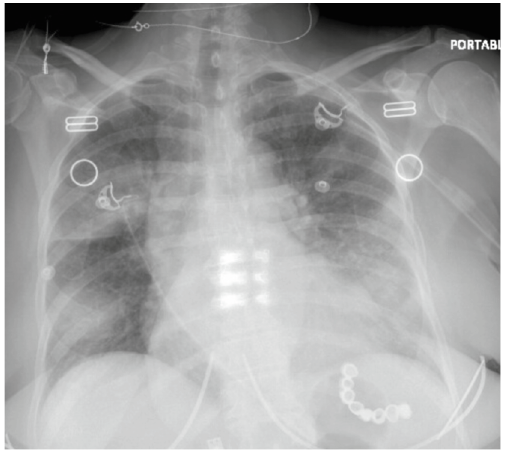
Figure 1: Portable posterior-anterior chest X-ray on admission showing multifocal ill-de fi ned hazy opacities appreciated